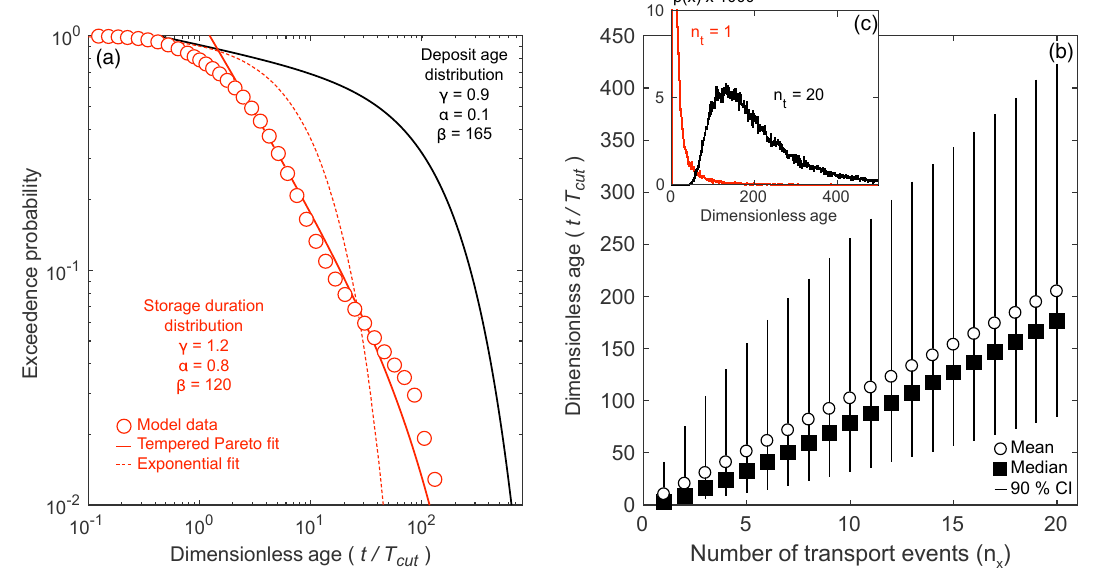
Figure 3. Dimensionless age distributions. (a) The survival function (complementary cumulative distribution function) of sediment storage durations (red points) derived from the meandering model. The sediment storage durations are normalized by a cutoff time ( T cut ) of 350 years based on explicit tracking of meander bend growth following the approach of Schwenk et al. (2015). The best fitting tempered-Pareto and exponential distributions are shown as solid and dashed red lines, respectively. Also shown is a tempered-Pareto fit to the distribution of deposit ages at the end of the model simulation (black line). (b–c) The change in the shape of the sediment transit time distribution (normalized by T cut ; Eq. 3) with increasing number of transport events. (b) The mean, median, and 90% confidence interval of the sediment transit time distributions for 1 to 20 transport events. (c) The probability density function of sediment transit time distributions for 1 and 20 transport events. Consistent with the central limit theorem, the shape of the sediment transit distribution varies with the number of transport